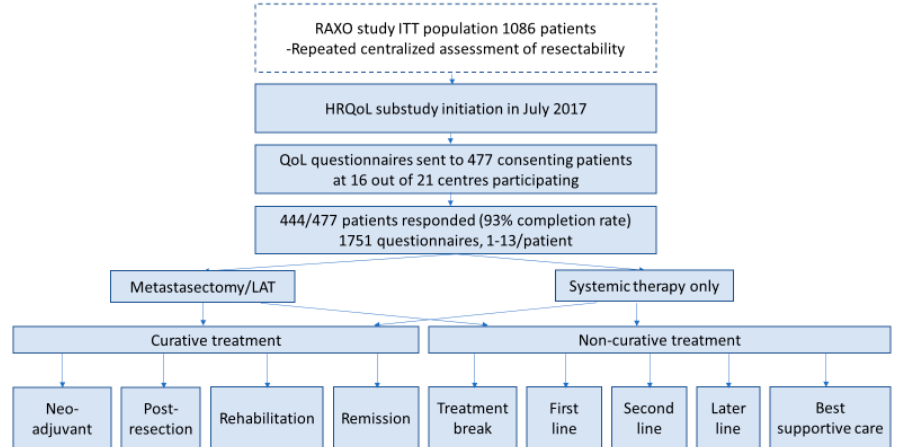
Figure 1. Study design, patient flow, Health-Related Quality of Life (HRQoL) questionnaires, and in- tervention with resectability assessments and metastasectomy and/or local ablative therapy (LAT) rates at a centralized multidisciplinary team (MDT) conference at a tertiary hospital in the Finnish nationwide RAXO-study. The exact patient flow between groups/phases and questionnaires per treatment phase are described in Table